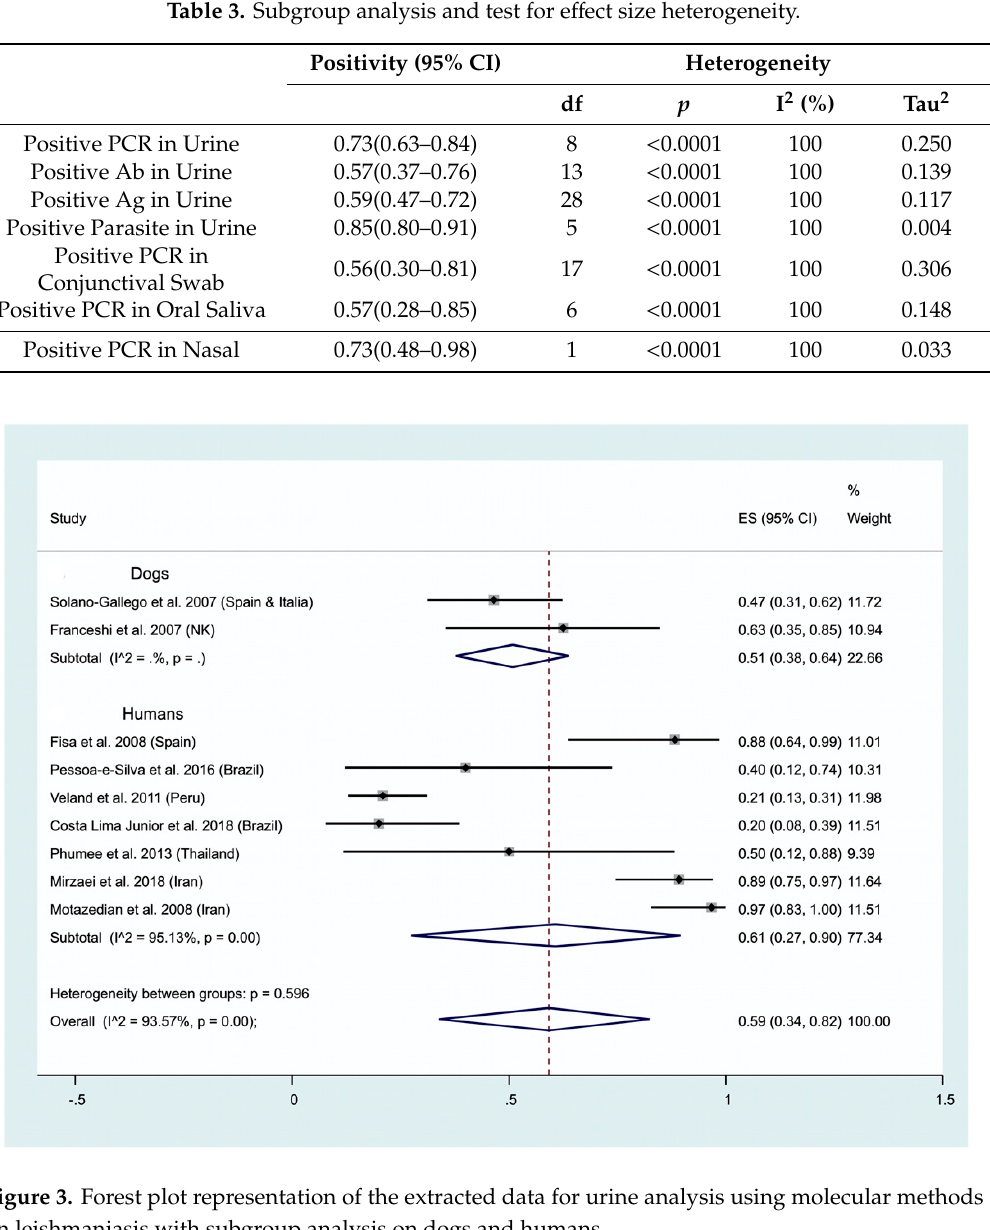
Table 3. Subgroup analysis and test for e ff ect size heterogeneity.